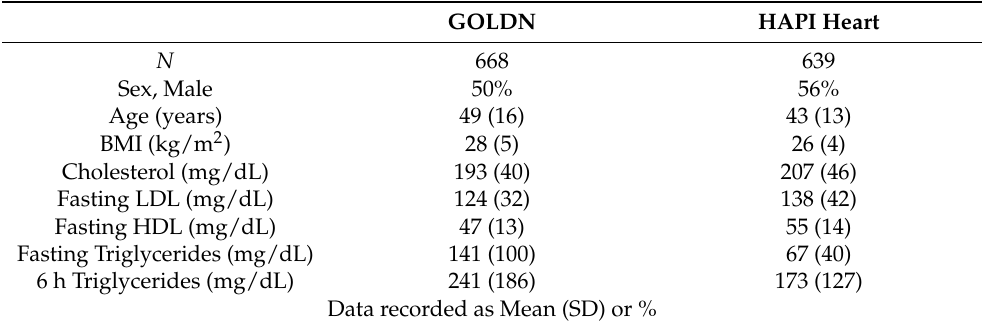
Table 1. Demographic and clinical characteristics of the HAPI Heart cohort and the GOLDN cohort. GOLDN HAPI Heart N 668